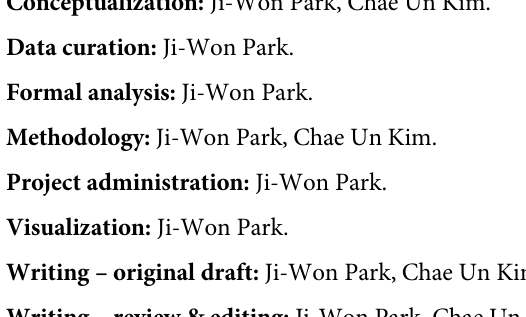
S3 Table. Actual and optimal income distributions in China from 1990 to